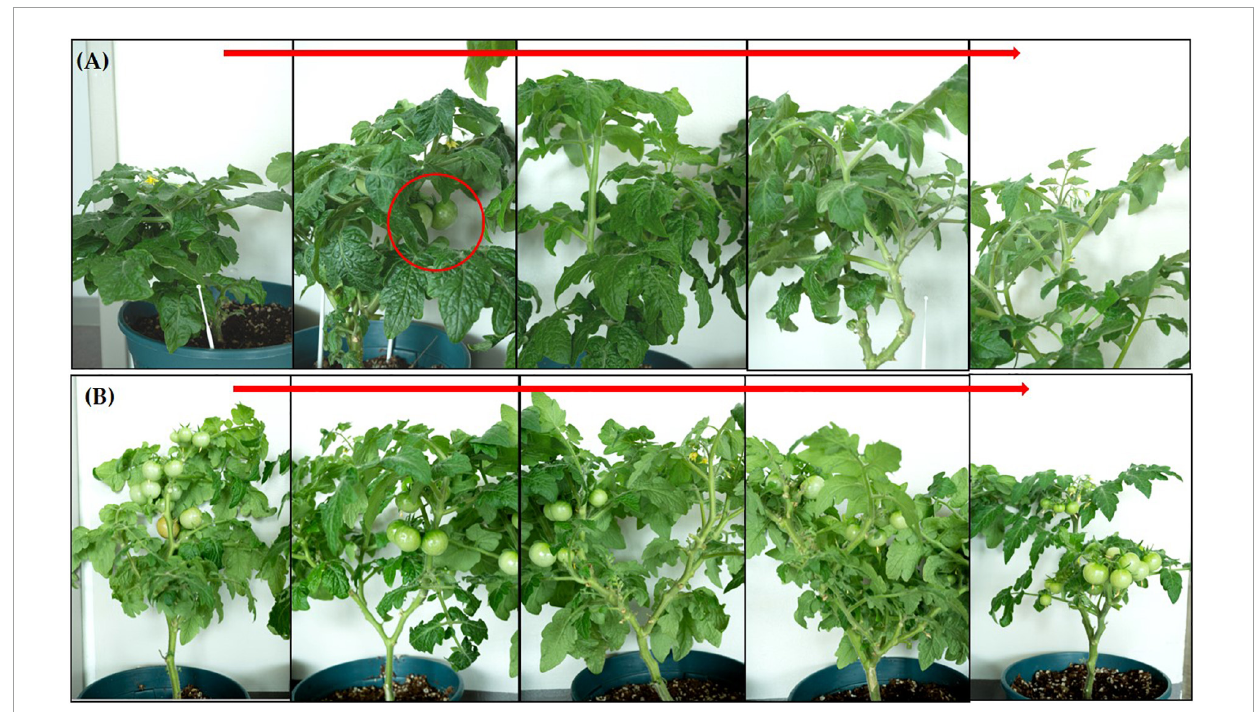
FIGURE4 Increase in fruit yield found in tomato plants when inoculated with Paraburkholderia species RG36 T . (A) Control or non-treated plants showed only three fruits among five plants. However, inoculated plants showed more than ten tomatoes yield in each plant (B)